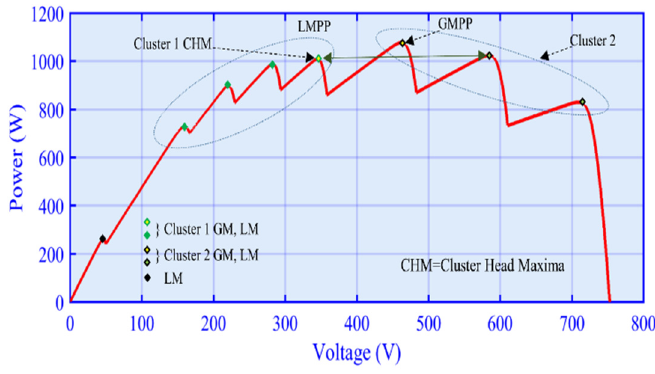
Figure 6. Cluster formulation of the CPS scenario.